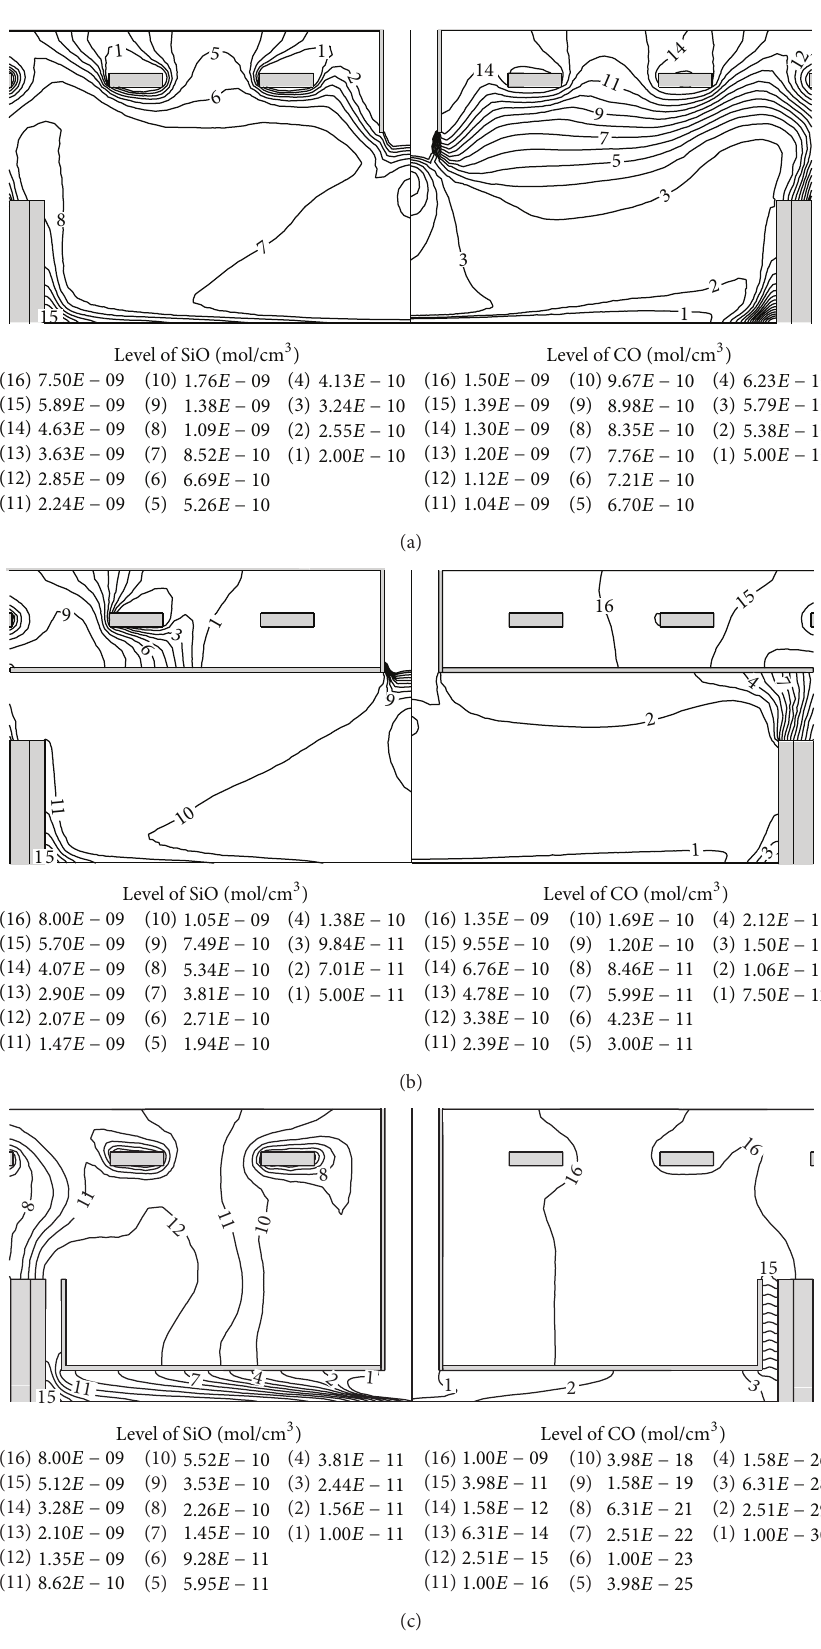
Figure 4: Distributions of SiO (left) and CO (right) concentration above the melt free surface for different cover designs without surface reaction: (a) no cover, (b) flat cover, and (c) U